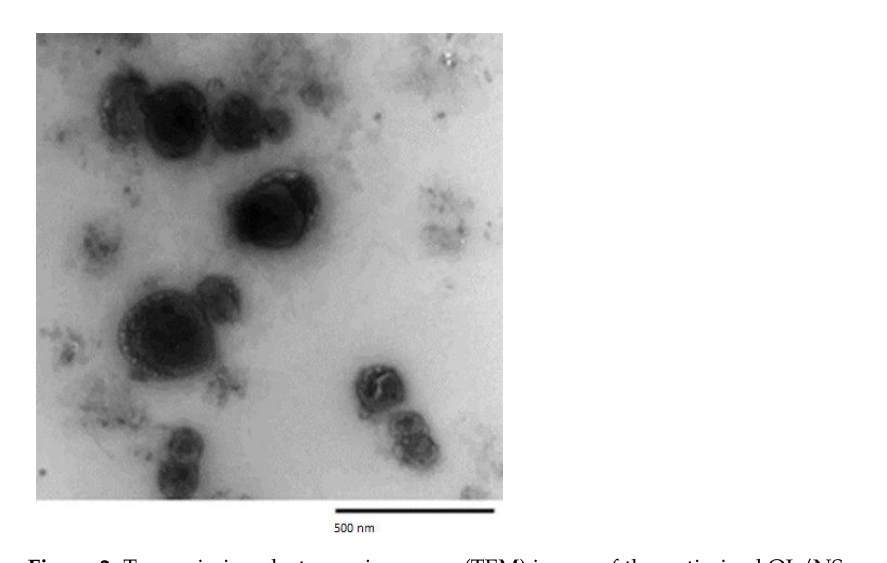
3208.9 cm −1 , (OH stretching), 2670.8 cm −1 (C-H stretching), 1490.7 cm −1 (C-C stretching), and 1211.0 cm −1 (C-O stretching) [29]. The FTIR spectrum of plain niosomes (Figure 3B) ing), 1467.6 cm −1 (C-H bending), and 1093 cm −1 (C-O stretching) [30]. On the other hand,